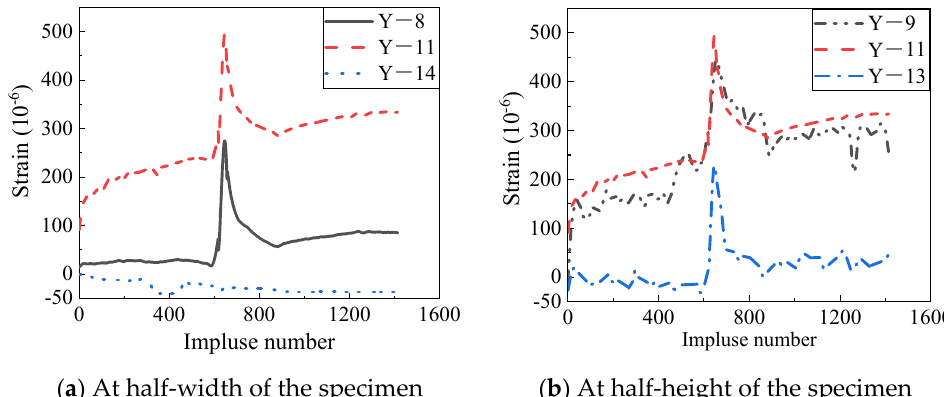
Figure 11. Envelope strain responses of the decorative panel.